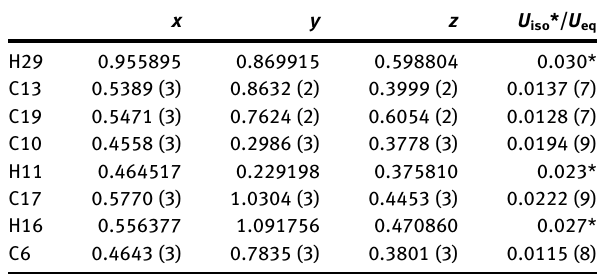
Table  : Fractional atomic coordinates and isotropic or equivalent isotropic displacement parameters (Å 